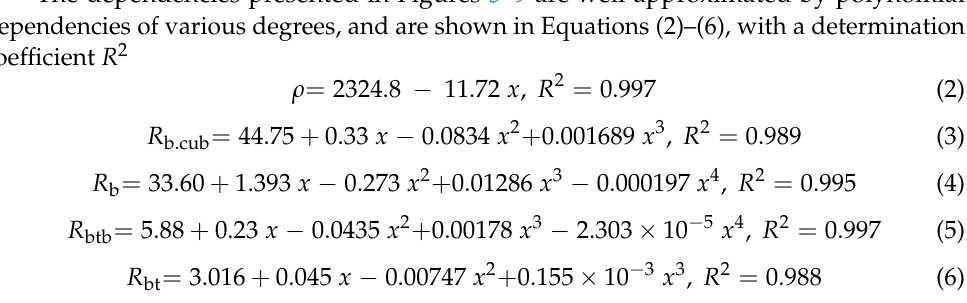
Figure 9. Dependence of the axial TS of concrete on the amount of walnut shell.